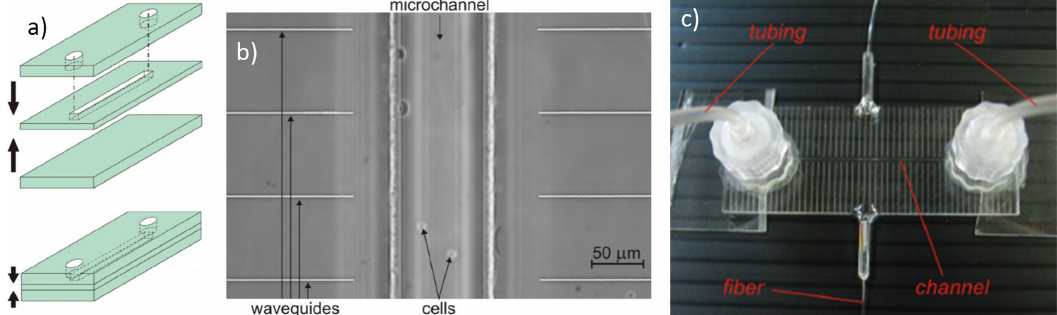
Figure 5. ( a ) Schematic representation of the three-layer technology for the monolithic optical stretcher fabrication. The central fused silica glass is machined by Femtosecond Laser Irradiation followed by Chemical Etching (FLICE) technique for the central channel and then sealed on both sides with two polished glass slides; ( b ) Microscope image of the straight microfluidic channel with pairs of waveguides beside it; ( c ) The finished chip is pigtailed with optical fibers and connected with external tubing through Luer connectors. Figure reproduced from Reference [29] with permission from Optical Society of